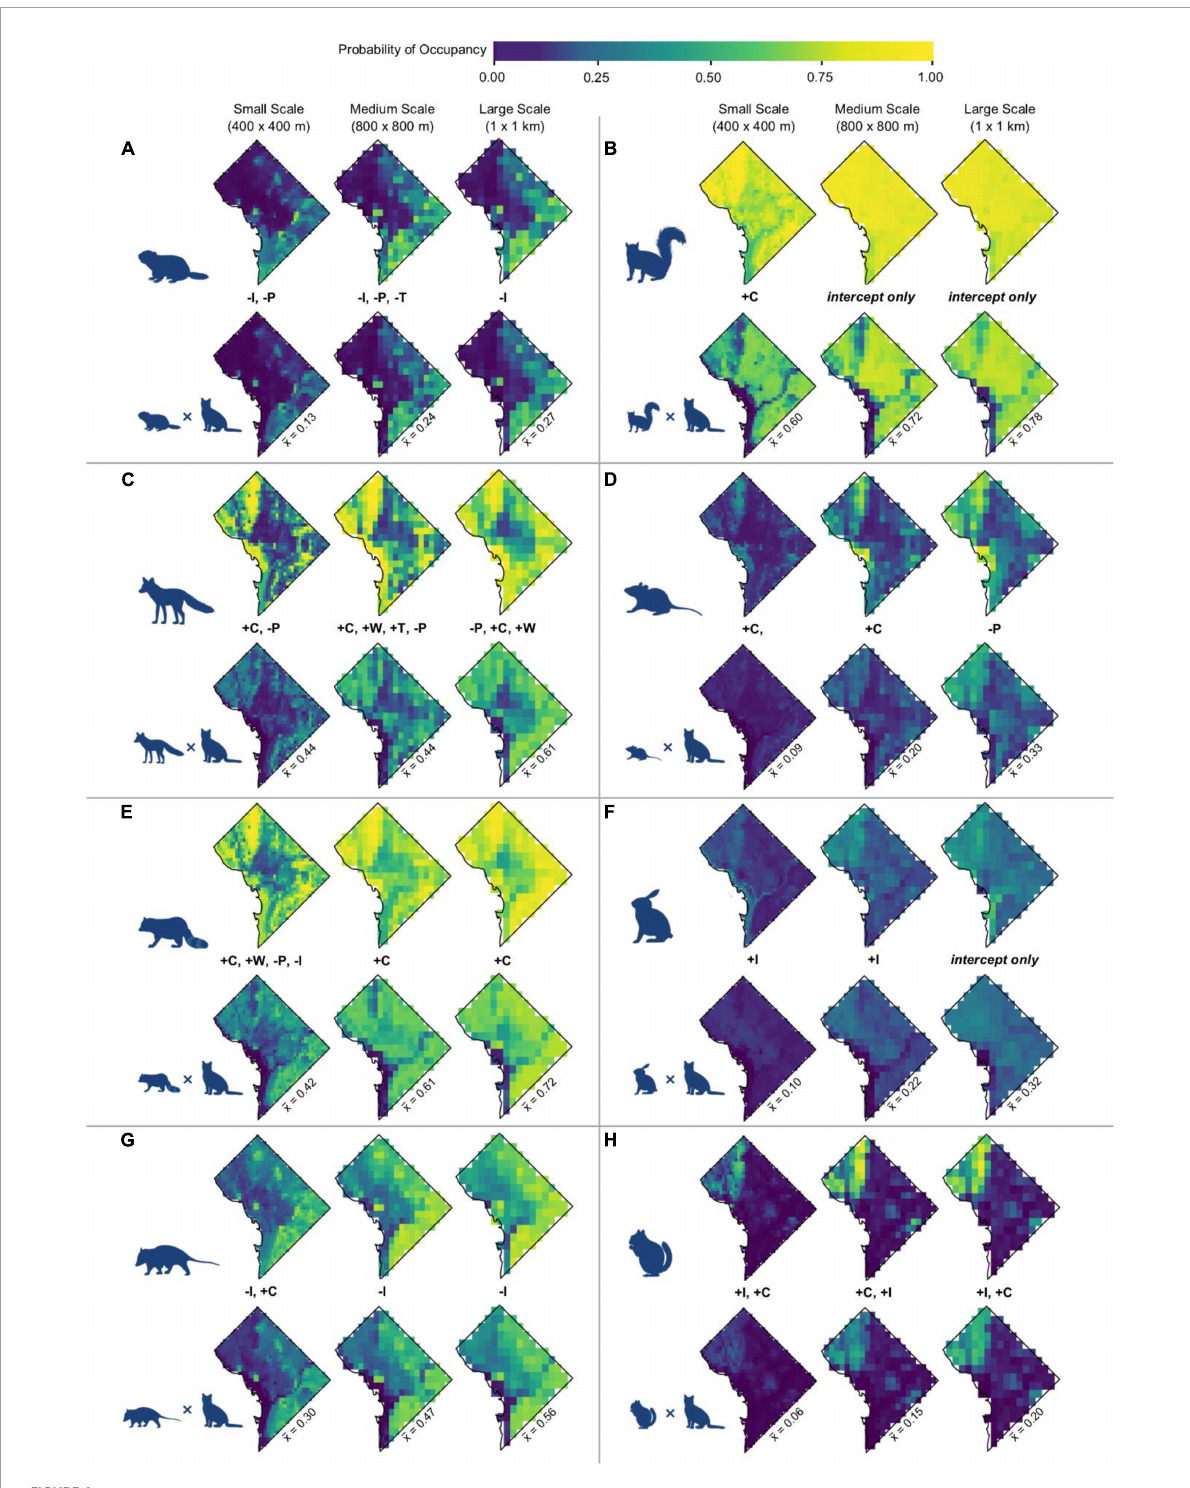
FIGURE4 Predicted occupancy probabilities and probability of spatial overlap with cats for (A) groundhogs, (B) eastern gray squirrels, (C) red fox, (D) white-footed mice, (E) raccoon, (F) eastern cottontail, (G) , Virginia opossum, and (H) eastern chipmunk across Washington, DC. Occupancy color gradient is identical to Figure 2 . For each species, the top row depicts the median occupancy probability across the study area. The second row for each species depicts the median probability of spatial overlap. Maps depicting predicted occupancy and overlap probabilities at the upper and lower limits of the 95% credible interval are available in Supplementary Appendix 4